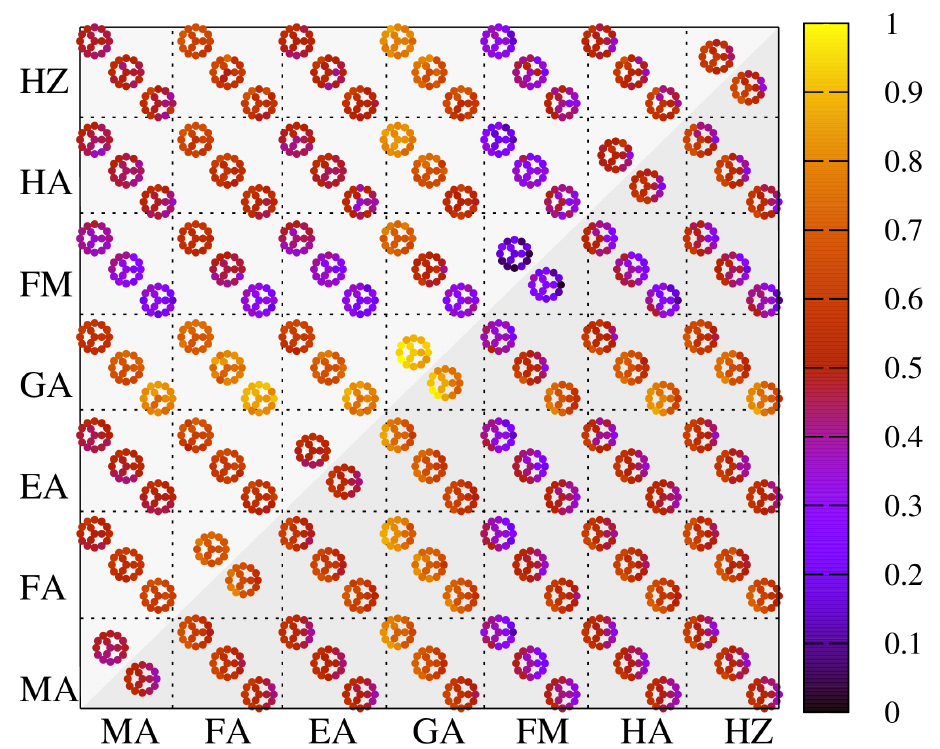
Figure 6. Stability assessment according to the intrinsic degradation mechanism (upper left tri- angle) and extrinsic mechanism based on O 2 addition (lower right triangle), as described by Equations (2) and (3),